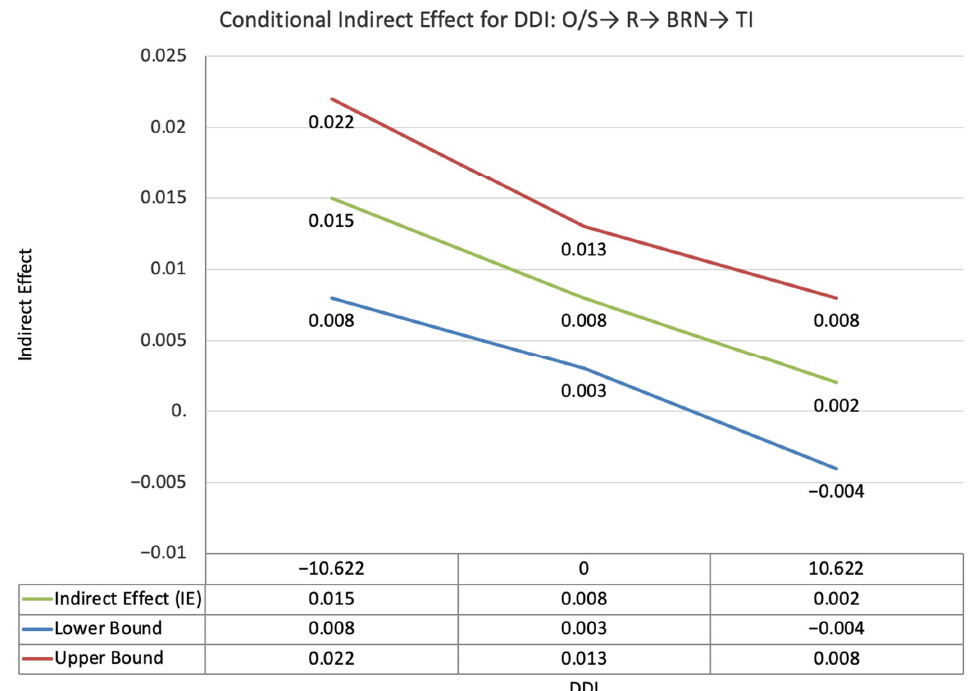
Figure 11. Conditional indirect effects of the difference between self-PMIEs compared to other-PMIEs on turnover intentions at low, average and high levels of perceived supervisor support, through autonomy satisfaction and work engagement.